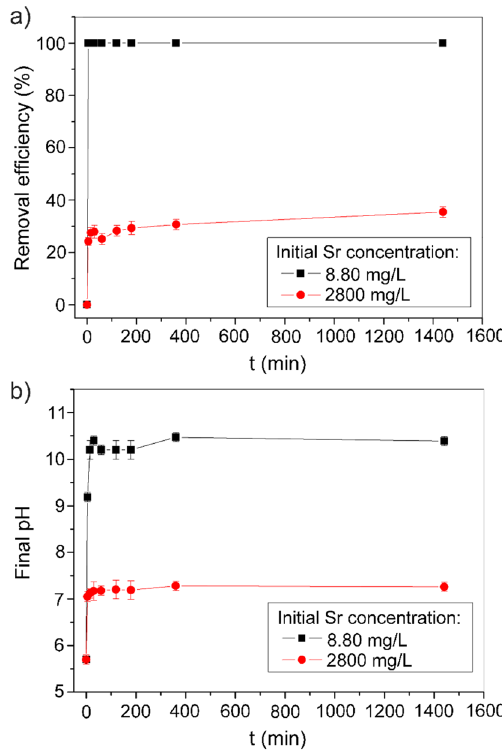
Figure 3. Kinetics of Sr sorption by Z4A from single-component solutions with different initial concentrations: ( a ) process efficiency, ( b ) final pH